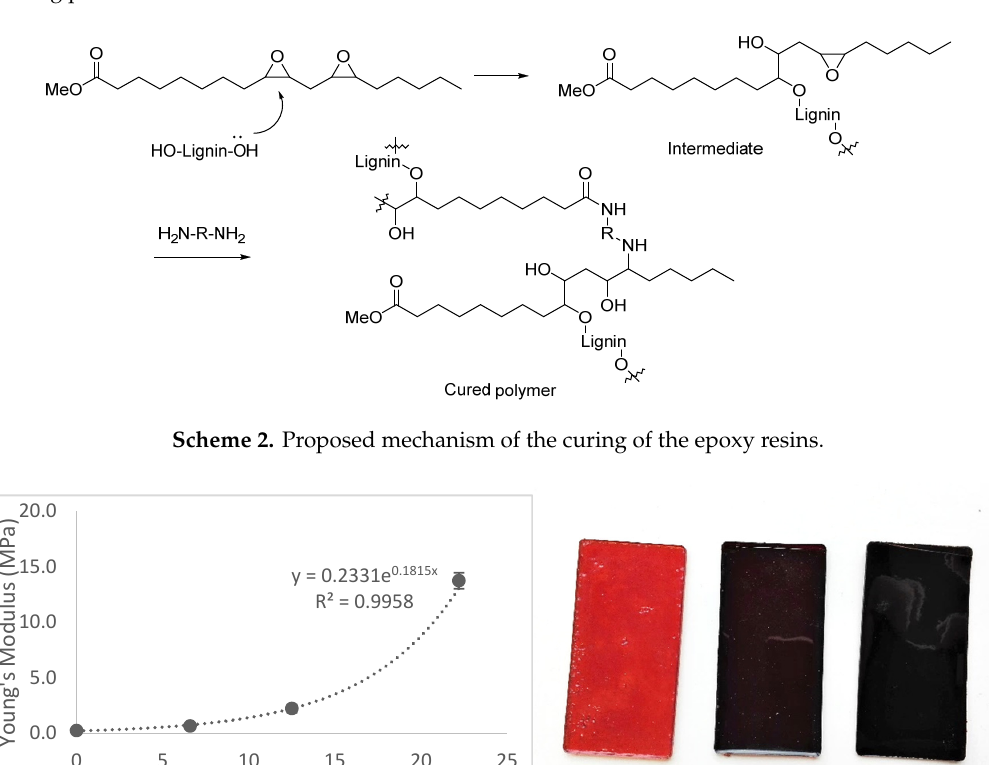
Figure 1. Infrared spectra of the starting materials and the evolution of the mixture during the curing process.